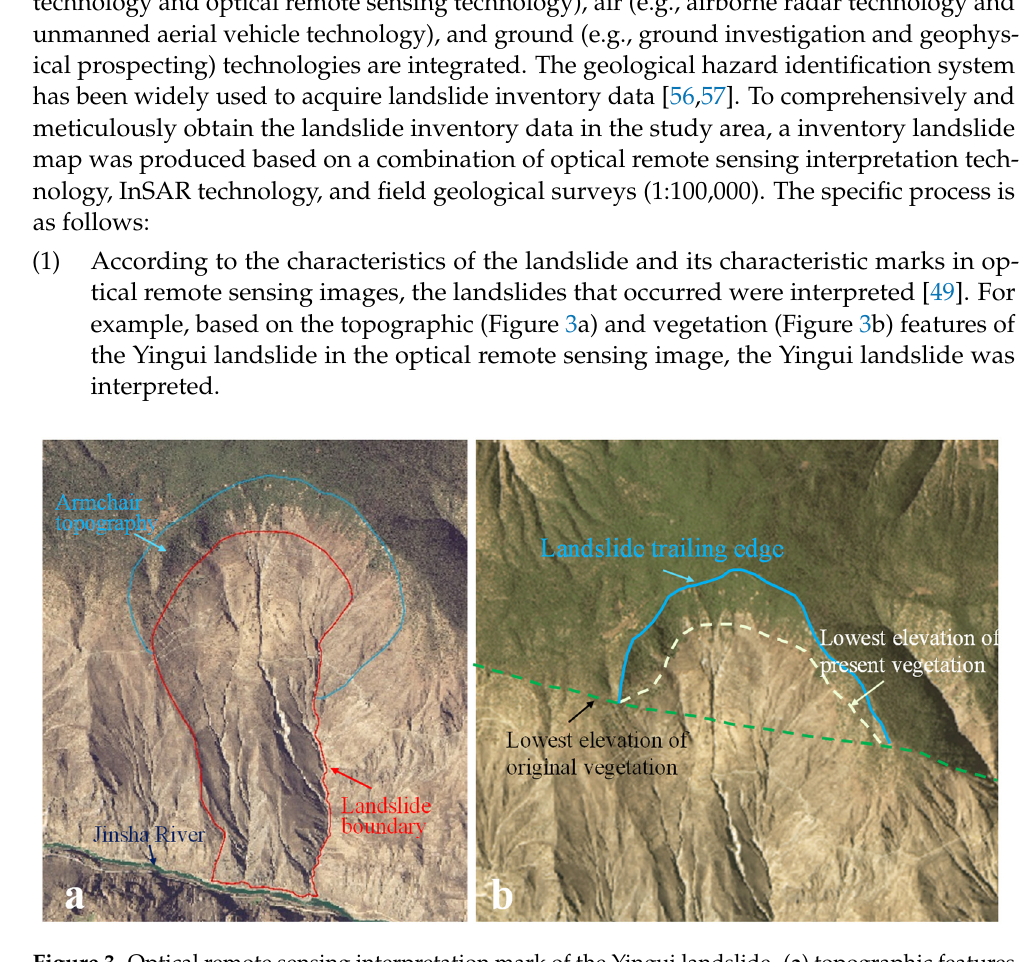
Figure 3. Optical remote sensing interpretation mark of the Yingui landslide. ( a ) topographic fea- tures of the Yingui landslide, and ( b ) vegetation features of the Yingui landslide. of the Yingui landslide, and ( b ) vegetation features of the Yingui